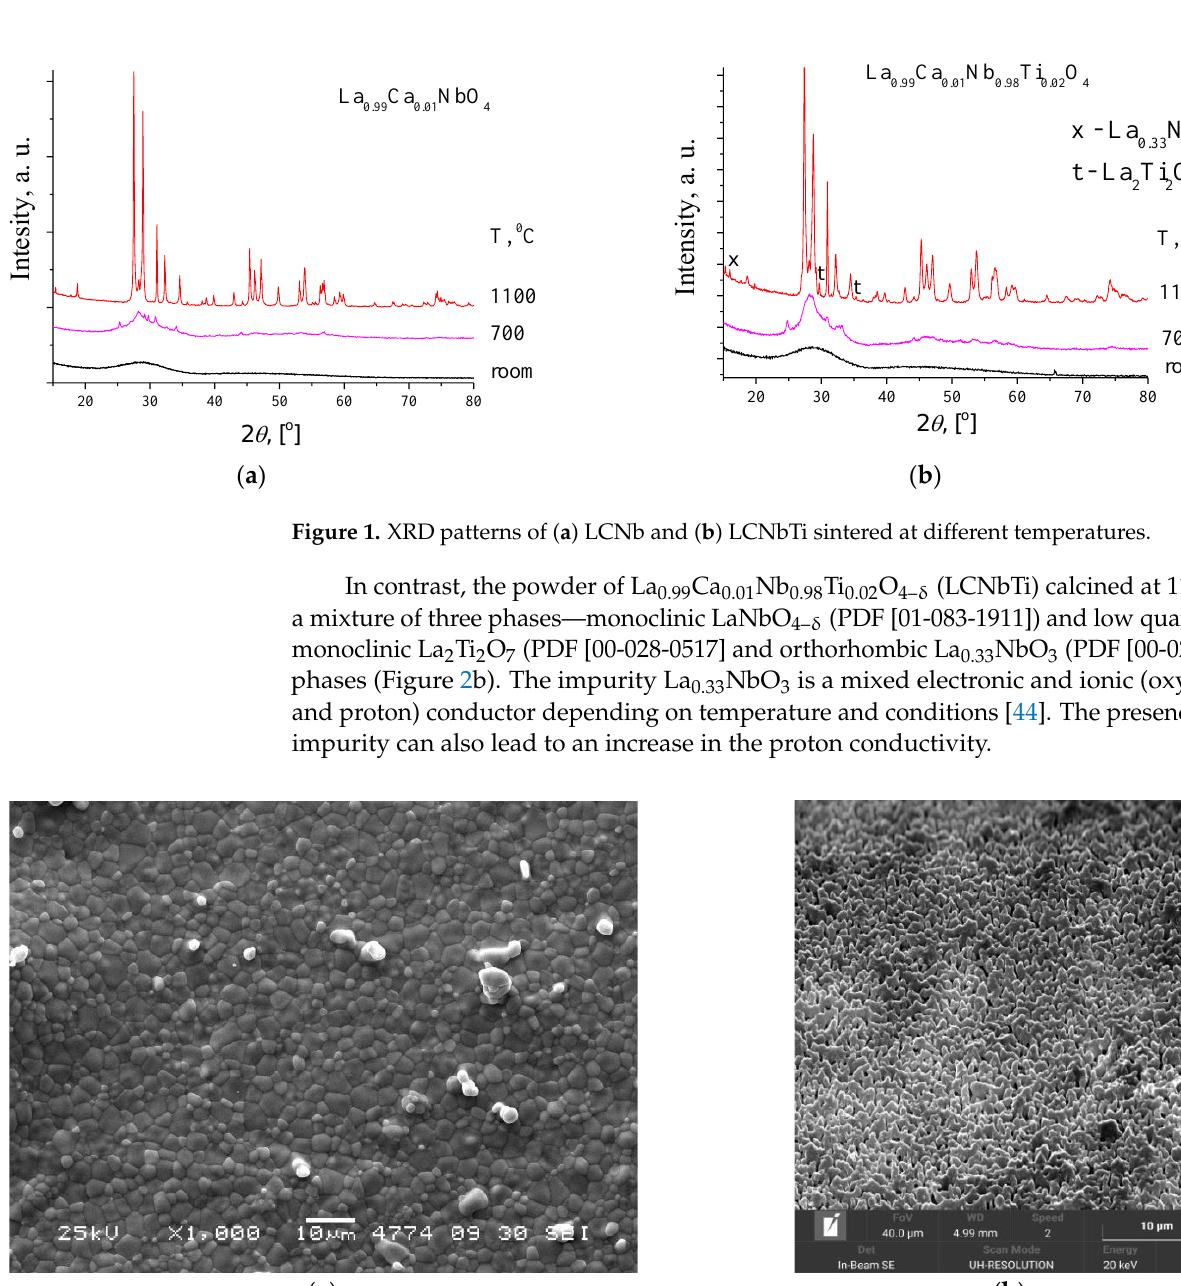
According to the XRD data, weakly crystallized phases of solid solutions of nickel, copper, and cobalt oxides are present immediately after drying the obtained suspension. During synthesis in supercritical medium, nickel–copper alloys were obtained, and the metal cations were reduced in the reactor as a result of the interaction with supercritical isopropanol. Based on XRD data (Figure 3a) after treatment at 500 ◦ C in the air, the